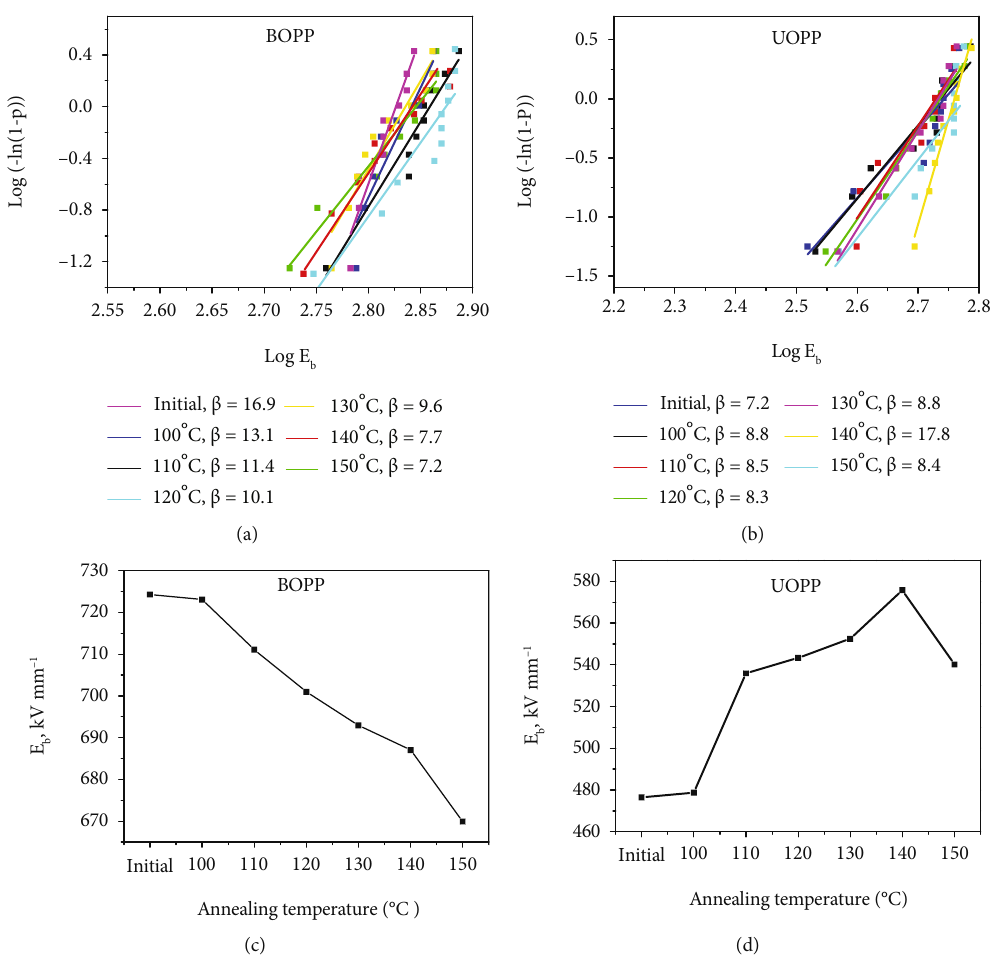
Figure 2: Weibull distribution and the E (d) UOPP fi